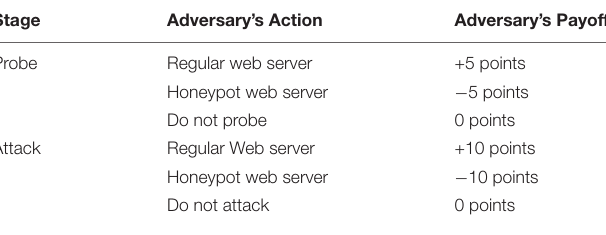
TABLE 1 | Adversary’s payoff during the probe stage and attack stage in the